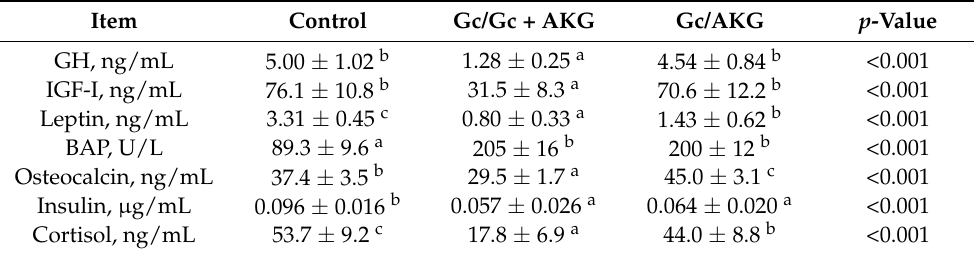
Table 2. The concentration of selected hormones and the activity of bone alkaline phosphatase (BAP) in the blood serum of 35-day-old